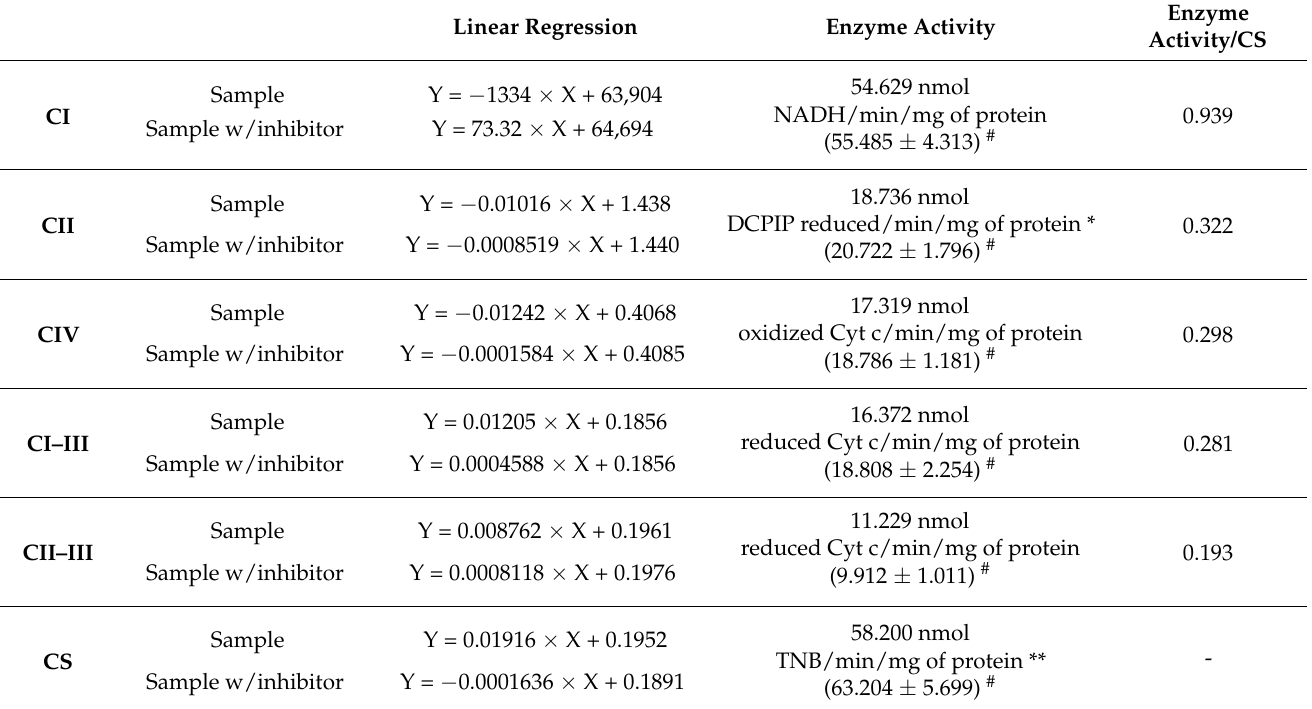
Table 12. Typical linear regressions for mitochondrial respiratory chain complexes were obtained in assays with 10 µ g of protein for “sample” and “sample with inhibitor” conditions, the enzyme activity normalized by mg of protein and the activity of each complex normalized by the CS activity. Linear Regression Enzyme Activity